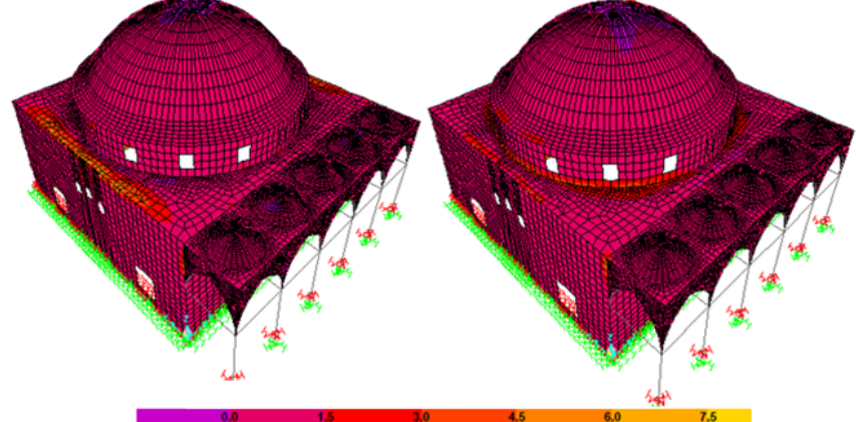
Figure 7. Maximum compression stresses contour diagram for the outer and inner surfaces of the mosque with 16 window openings under dead load and earthquake load (G + EX).